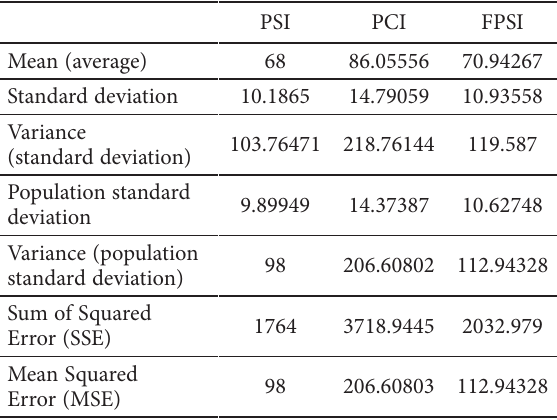
Table 5. Comparing of models statistical values PSI PCI FPSI